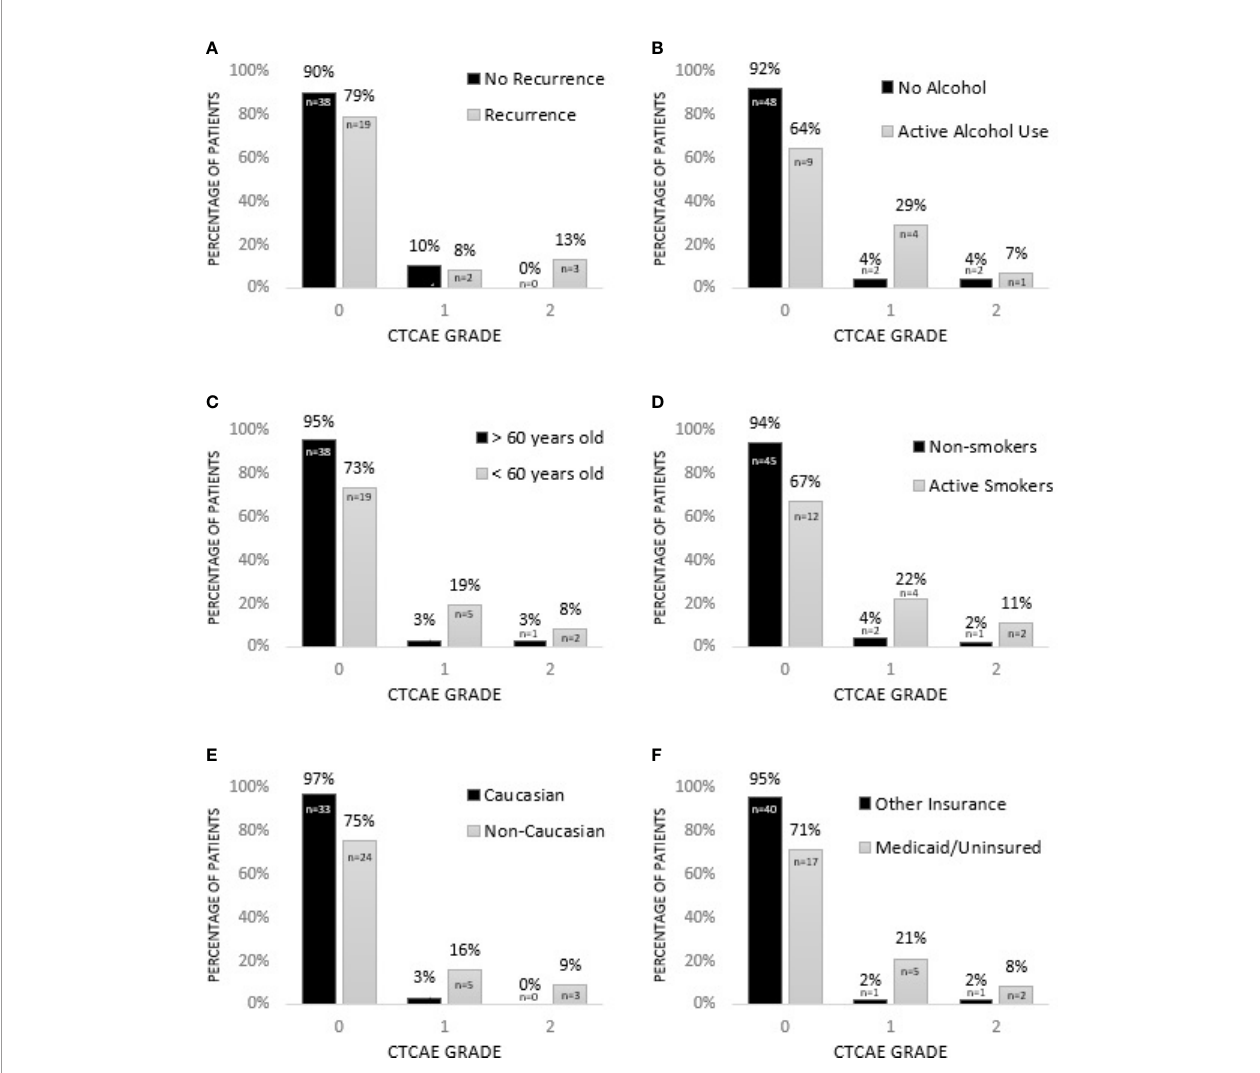
FIGURE 1 | Factors associated with increased grade of fi brosis in HNC patients treated with radiotherapy. (A) Patients being treated for recurrent HNC experience higher grade of fi brosis ( p = 0.033*). (B) Consumption of alcohol during treatment is associated with higher grade of fi brosis ( p = 0.013*). (C) HNC patients younger than 60 experience higher grade of fi brosis ( p = 0.018*). (D) Smoking during treatment is associated with increased grade of fi brosis ( p = < 0.001*). (E) Non- Caucasian race is associated with increased grade of fi brosis ( p = 0.012*). (F) Grade of fi brosis in uninsured patients or patients with Medicaid approaches signi fi cance ( p = 0.054). * = signi fi